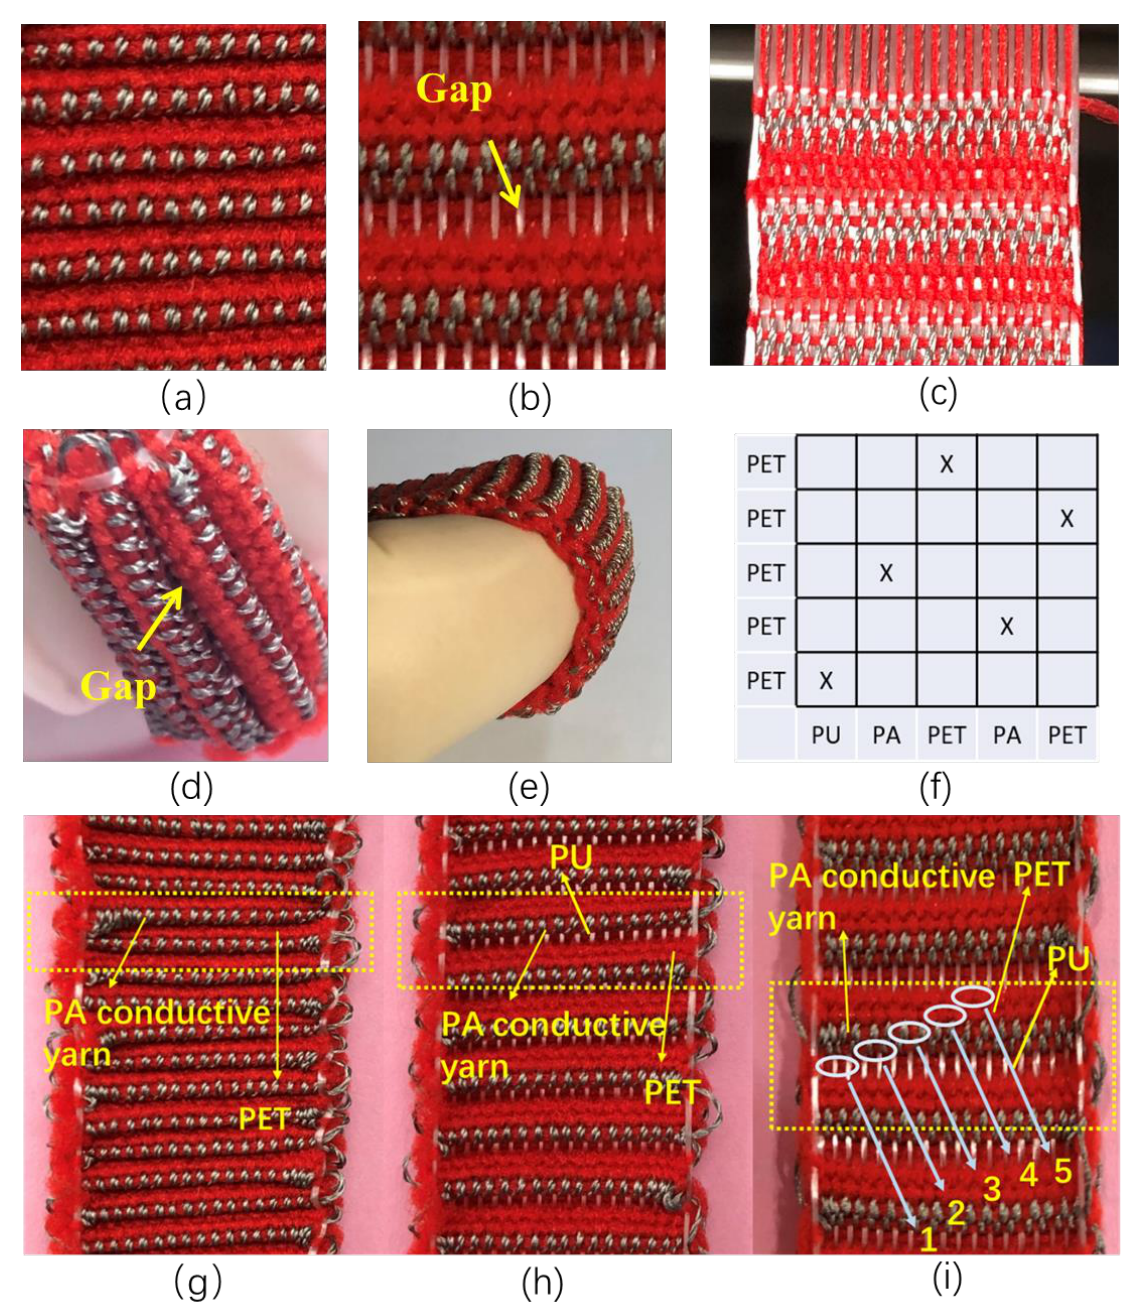
Figure 2. ( a ) SWF-TENG with satin weave before stretch; ( b , c ) SWF-TENG with satin weave after stretch; ( d , e ) The side view of SWF-TENG with satin weave; ( f ) Satin weave diagram; ( g ) SWF-TENG with satin weave before stretch; ( h , i ) SWF-TENG with satin weave after stretch. The working mechanism of SWF-TENG with satin weave under stretching mode is